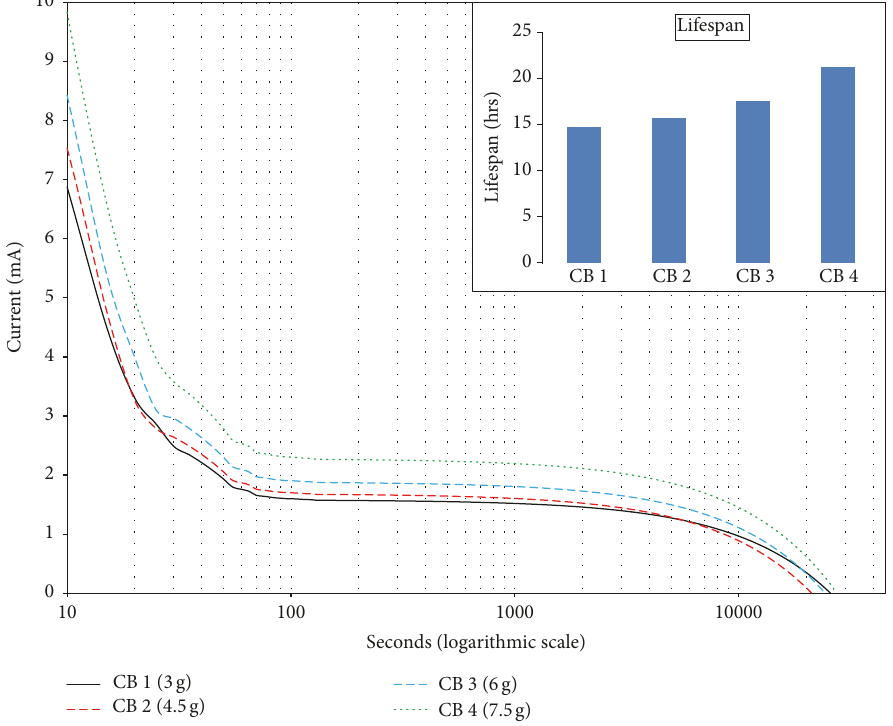
Figure 13: Current discharge curves across a 10 Ω resistor with increasing carbon black